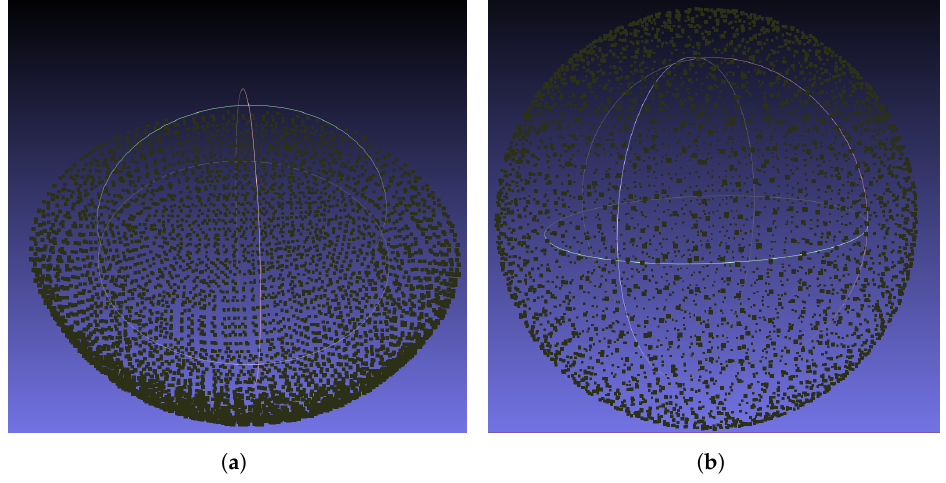
Figure 7. Points discovered while simulating a scan on a bowl and sphere of radius 150 mm with a sampling distance of 3 mm. ( a ) Concave shape sampling. ( b ) Sphere